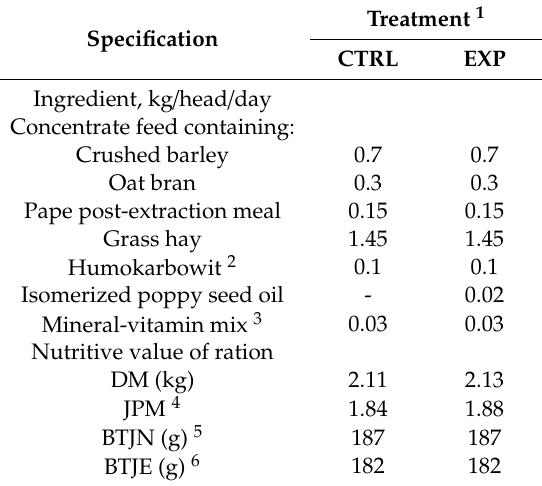
Table 3. Ingredients and nutritive value of sheep